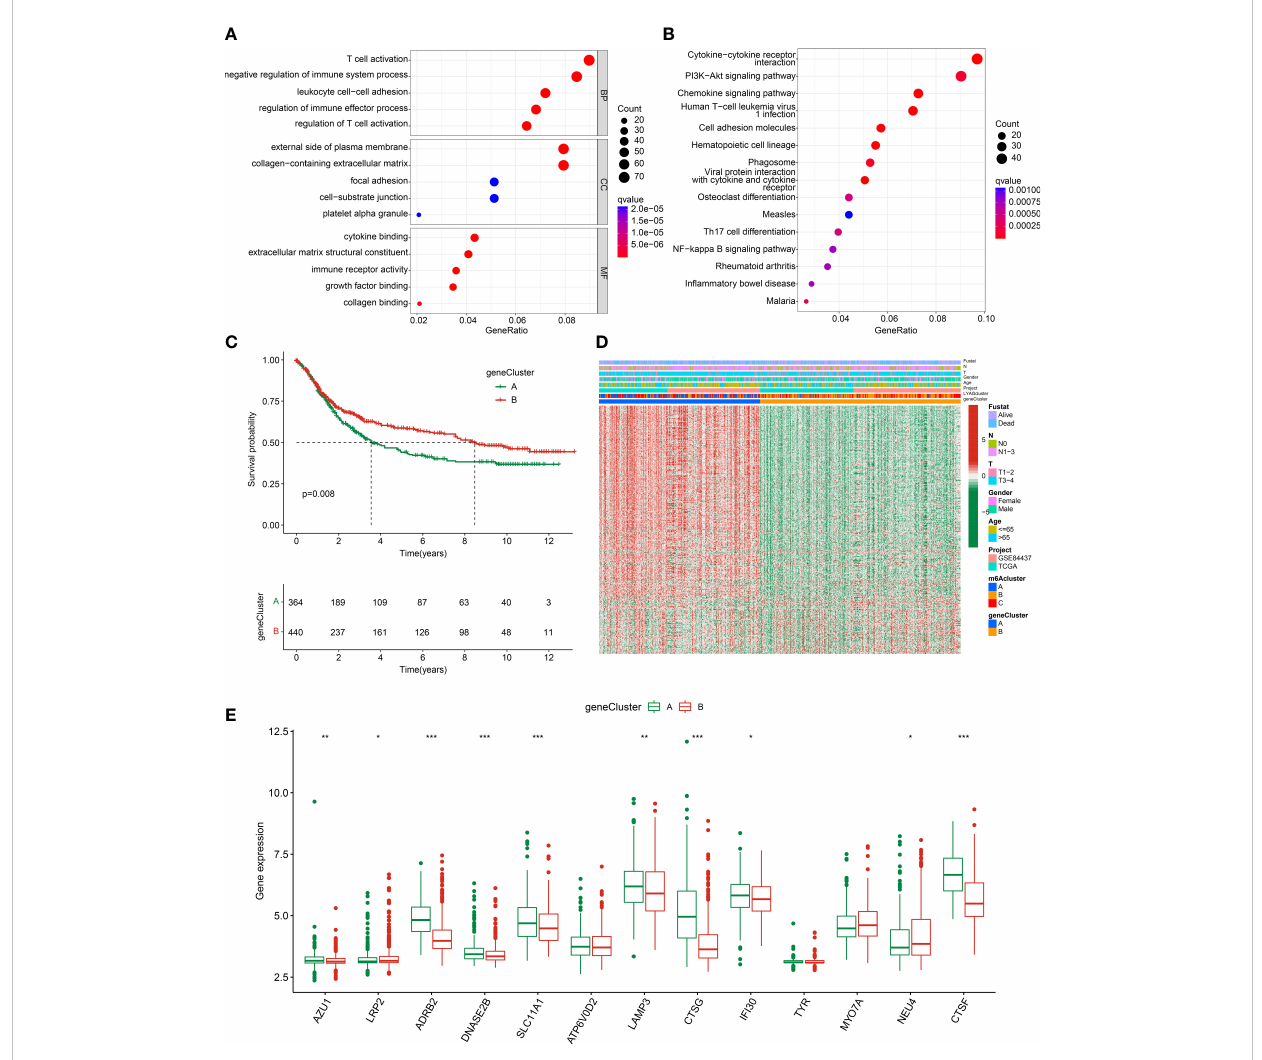
FIGURE 5 Gene cluster analysis based on the LYAG subtypes-related DEGs. (A, B) GO and KEGG enrichment analysis of LYAG subtype-related DEGs. (C) Prognostic survival analysis of GC in gene clusters. (D) Clinicopathological characteristics and DEGs expression pro fi le of GC in gene clusters. (E) LYAGs expression in gene cluster A and B. *p < 0.05, **p < 0.01, ***p <